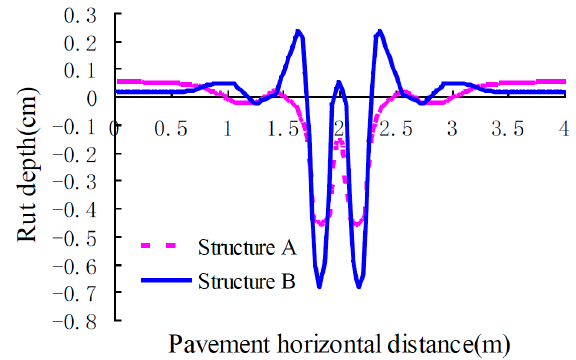
Figure 9. Calculation results of different pavement structure.